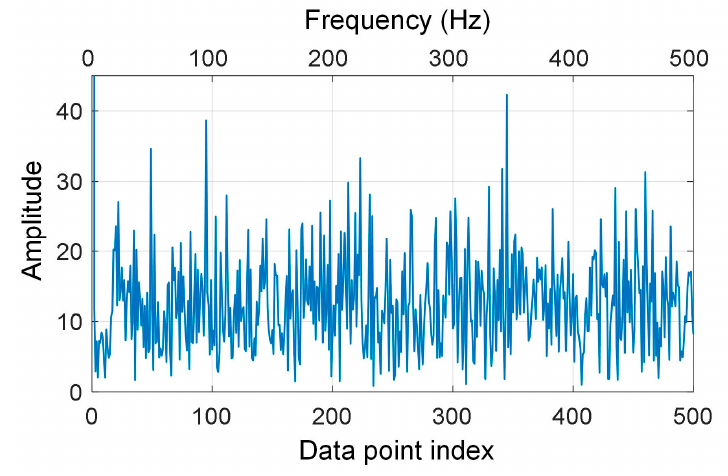
Figure 23. RPD: frequency spectrum of compressed vibration data.